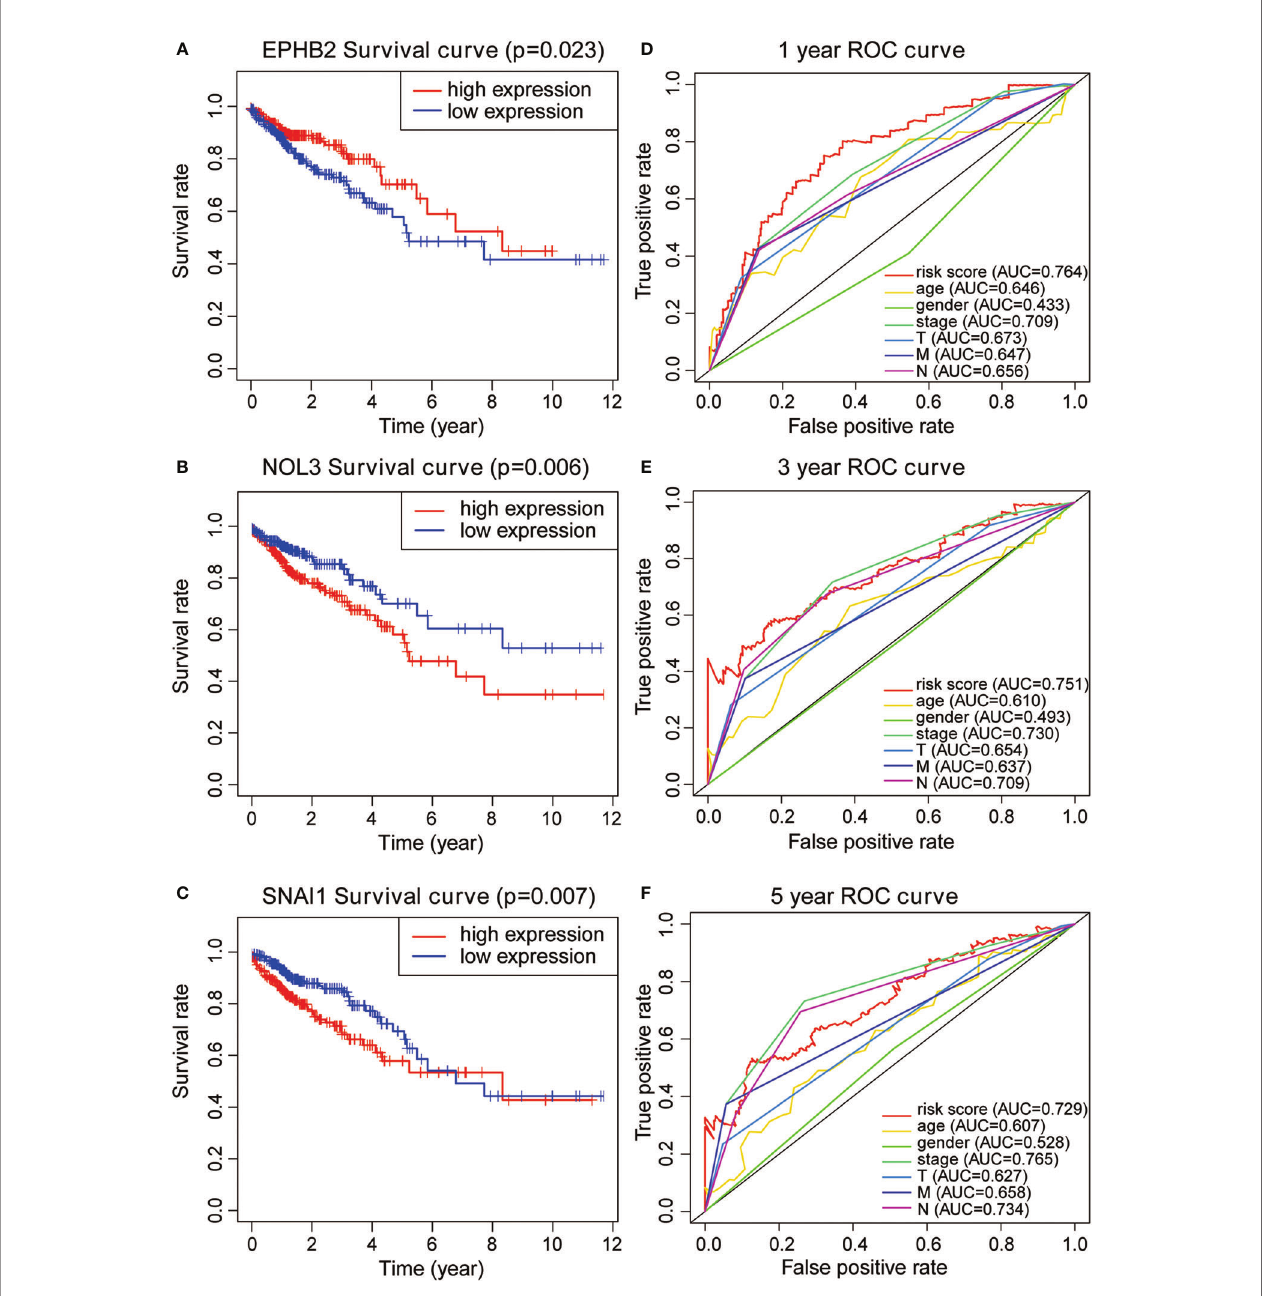
FIGURE 3 | (A – C) KM survival analysis for EPHB2, NOL3, and SNAL1. (D – F) 1-year, 3-year, and 5-year ROC curves and AUC based on the autophagy prognostic